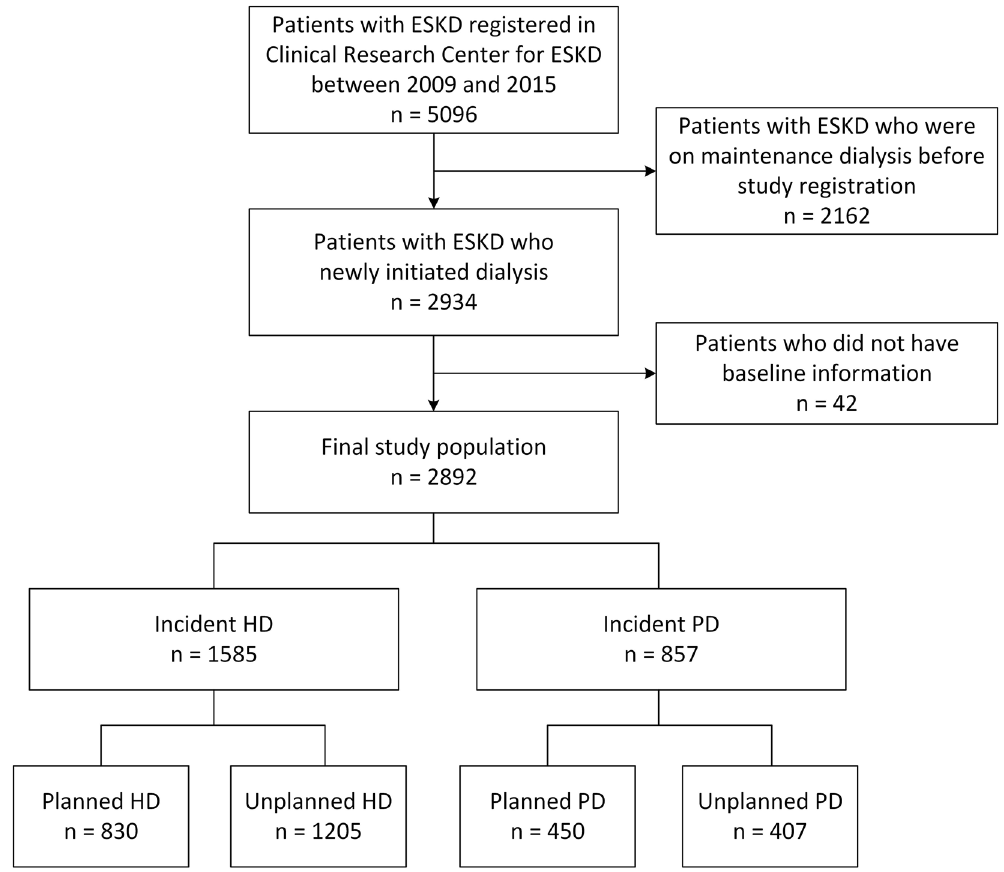
Figure 3. Study population. ESKD end-stage kidney disease, HD hemodialysis, PD peritoneal